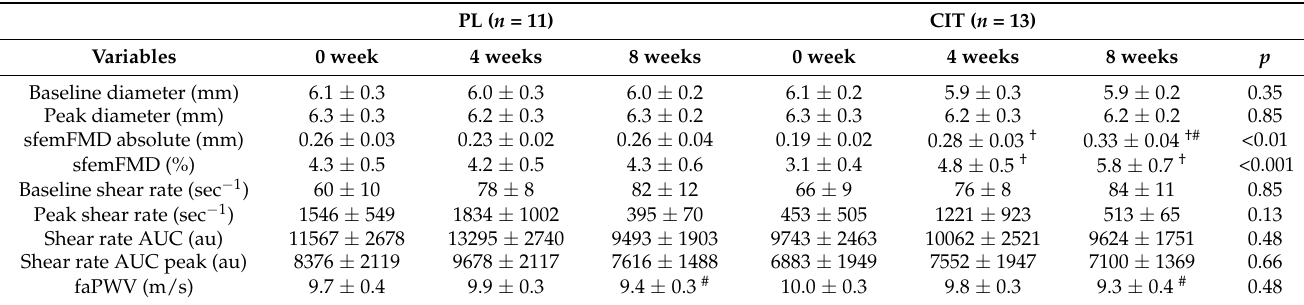
Table 2. Superficial femoral artery parameters and leg arterial stiffness at 0 (baseline), 4, and 8 weeks of placebo and citrulline supplementation alone (0–4 weeks) and combined with resistance training (4–8 weeks).